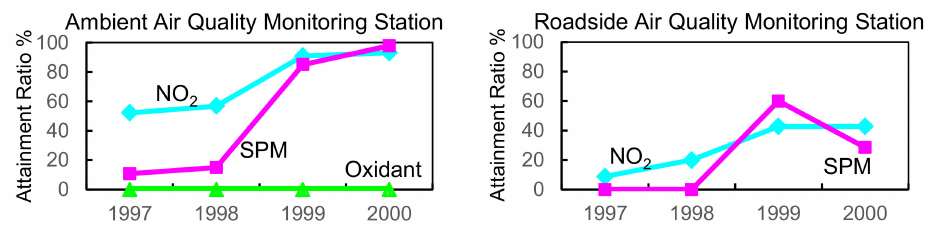
Figure 1. Attainment rate at general stations and roadside